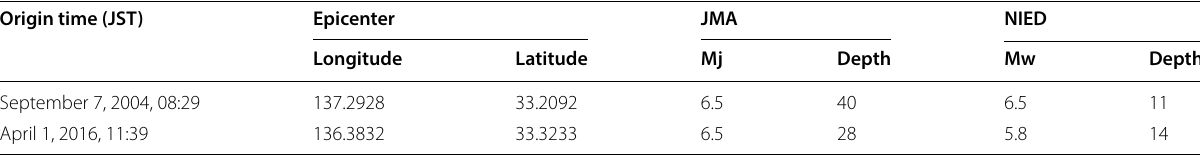
Table 1 Source parameters for the earthquakes used in the paper Origin time (JST) Epicenter JMA NIED Longitude